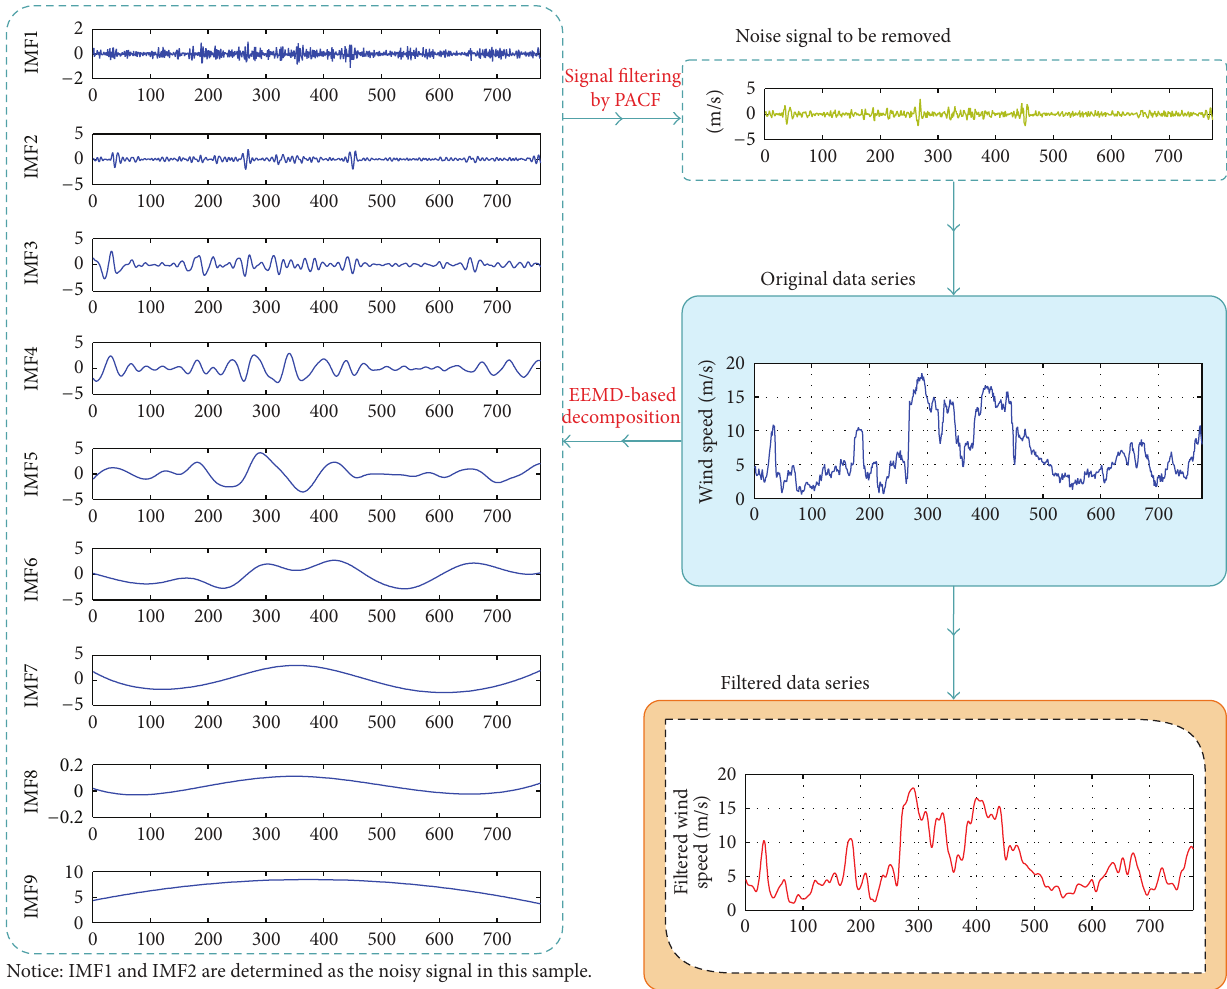
Figure 5: The decomposed signals by EEMD